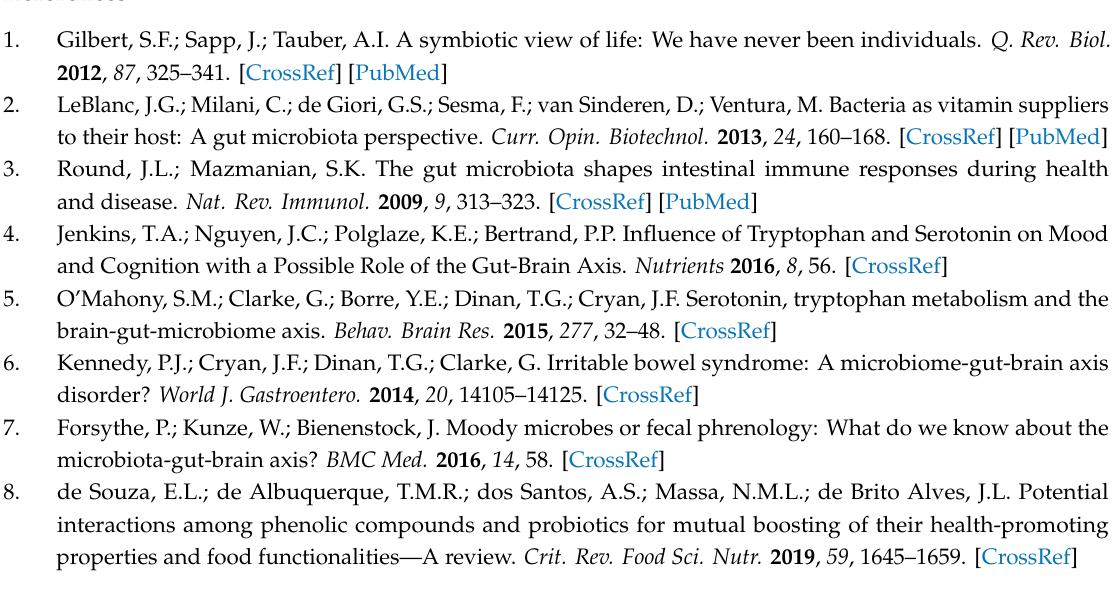
Table S1: Breed, sex and weight of the dogs recruited for the